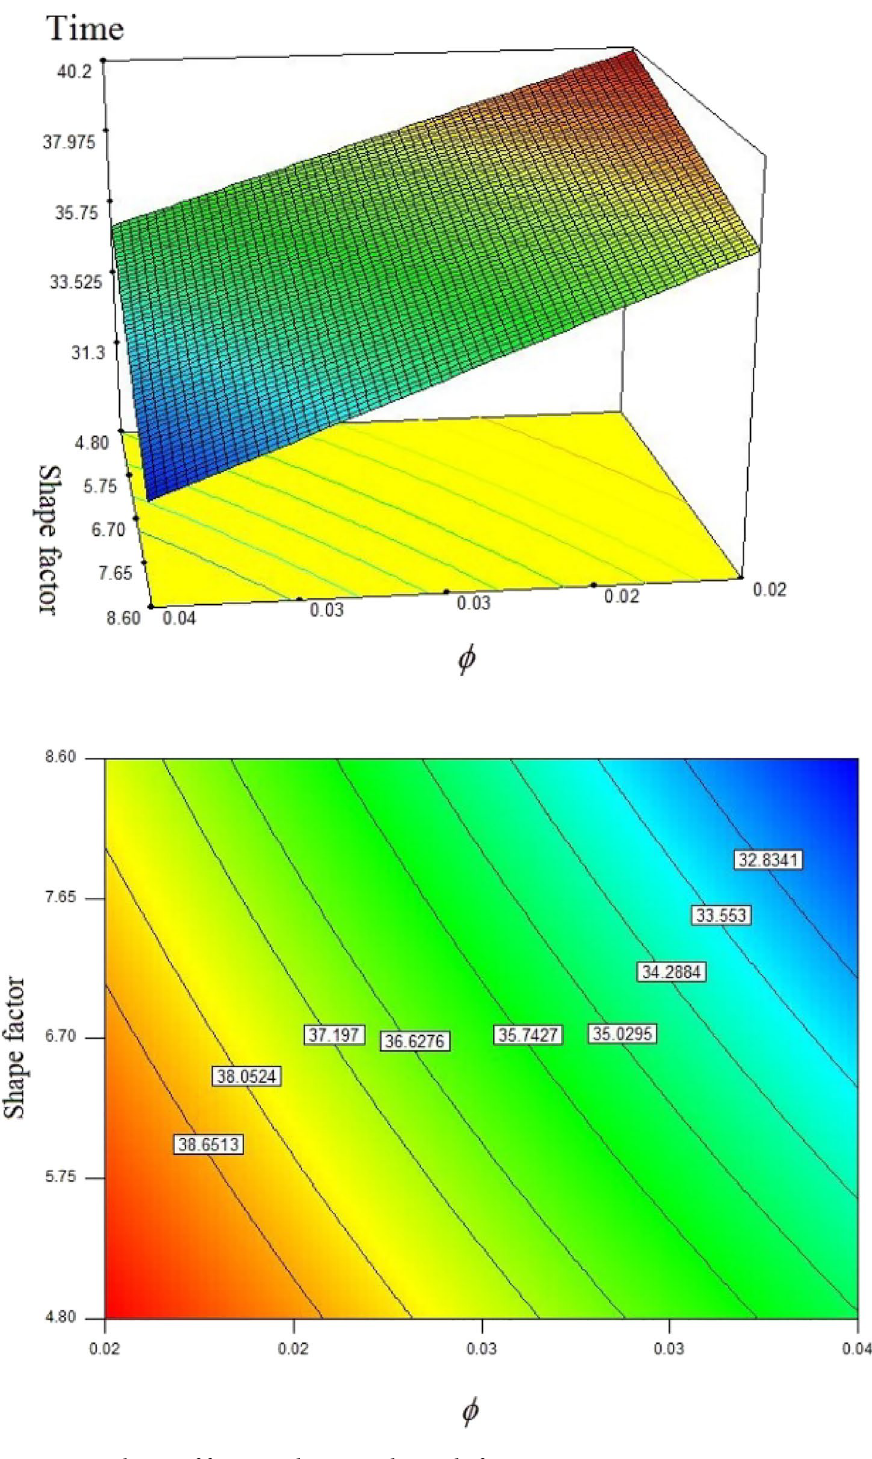
Figure 10. Change of factors and computed period of